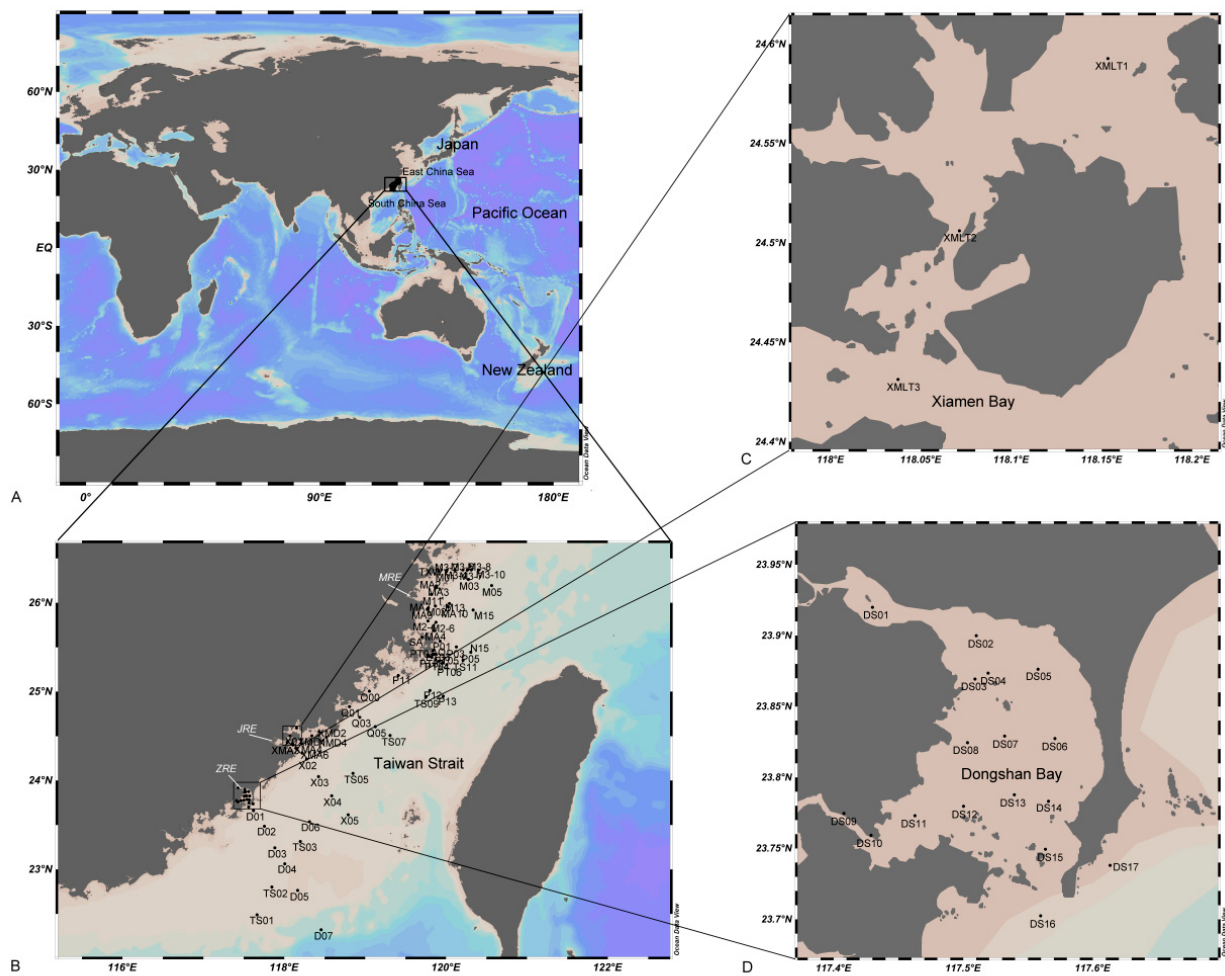
Figure 1. Sampling area and locations in the Taiwan Strait. ( A ) A world map showing the location of sampling areas. ( B ) Overview of stations (MRE: Minjiang River estuary, JRE: Jiulongjiang River estuary, ZRE: Zhangjiang River estuary). ( C ) Detailed view of the stations in Xiamen Bay. ( D ) Detailed view of the stations in Dongshan Bay.